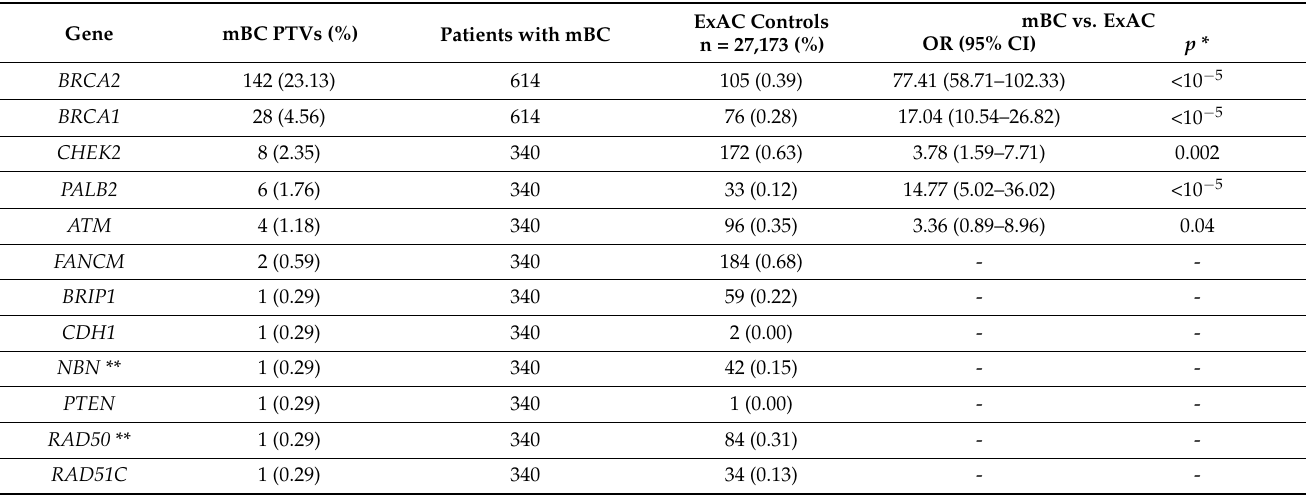
Figure 2. Prevalence of protein-truncating variants (PTVs) with binomial 95% confidence intervals (CIs) per gene in patients with male breast cancer and in ExAC controls. Table 2. Prevalence of protein-truncating variants (PTVs) in (suspected) cancer predisposition genes in patients with mBC compared with the control dataset (ExAC). Mutation carrier frequencies are shown in parentheses. Univariate logistic regression analysis was performed to estimate the odds ratios (OR) and corresponding 95% confidence intervals